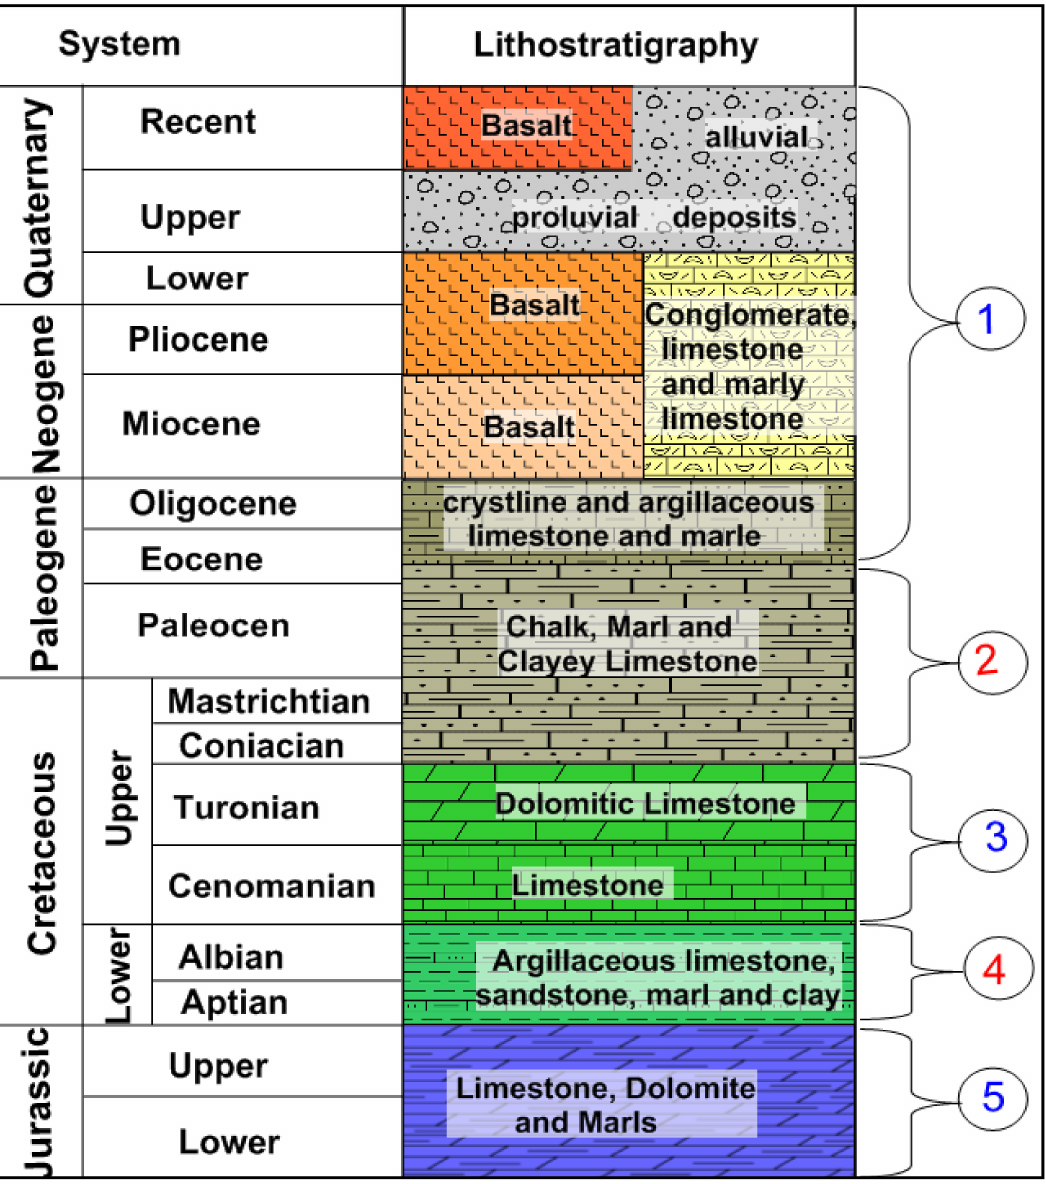
Figure 6. Different aquifers and aquitards discriminated in the study area, (after [30,31]). 1 , 3 and 5 are aquifers, 2 and 4 are